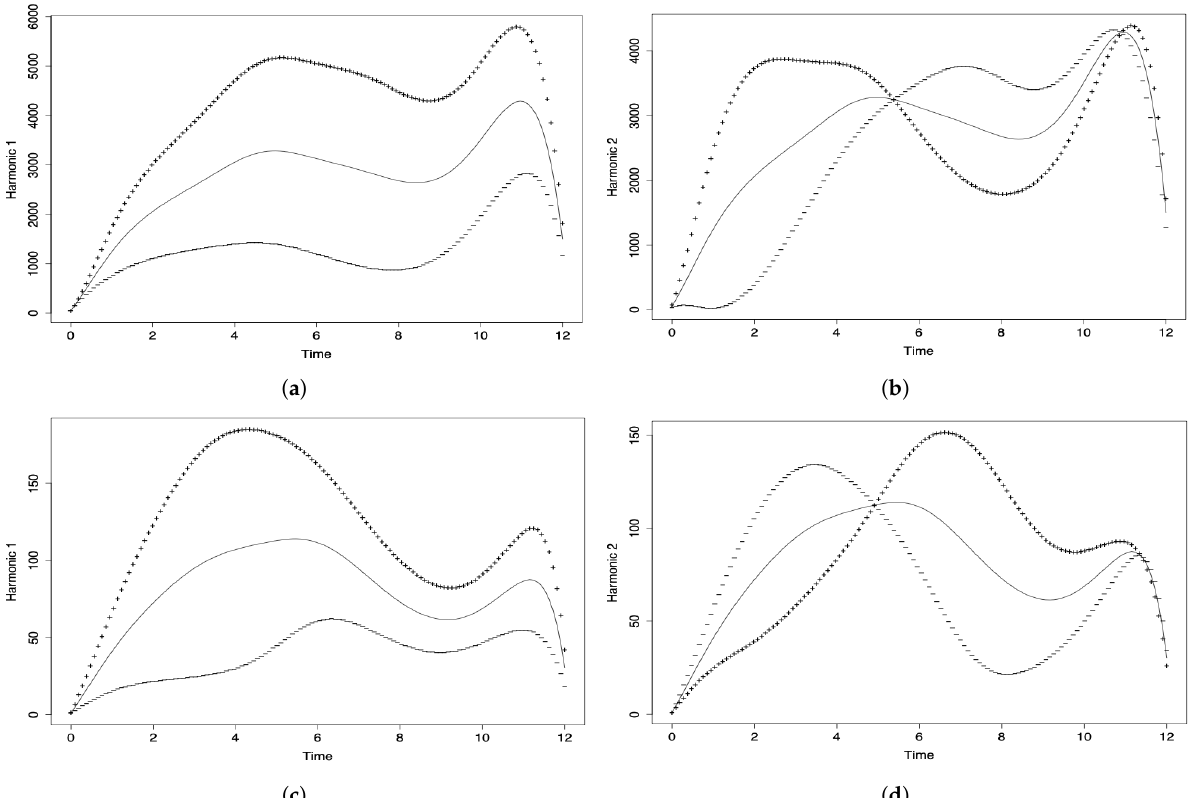
Figure 5. Harmonic components ( a,c ) 1 and ( b,d ) 2 of the FPCA for data on the number of COVID-19 ( a , b ) infected cases, and ( c , d )